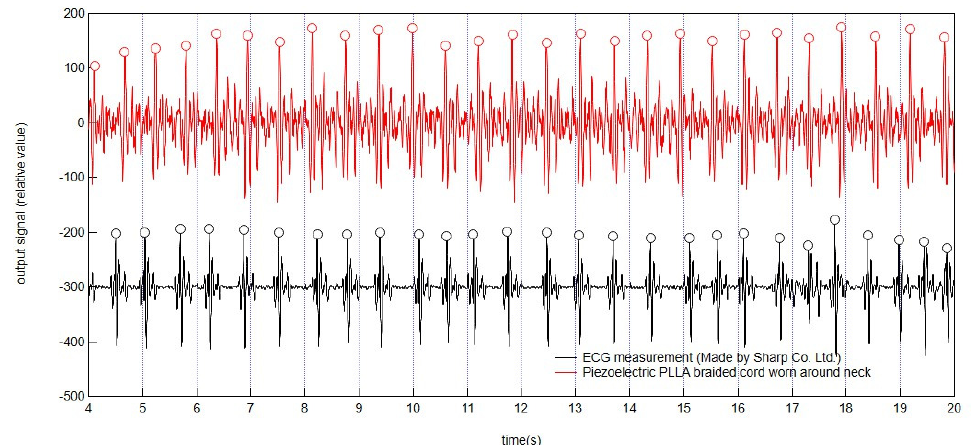
Figure 10. Waveforms of response signals from a piezoelectric PLLA braided cord